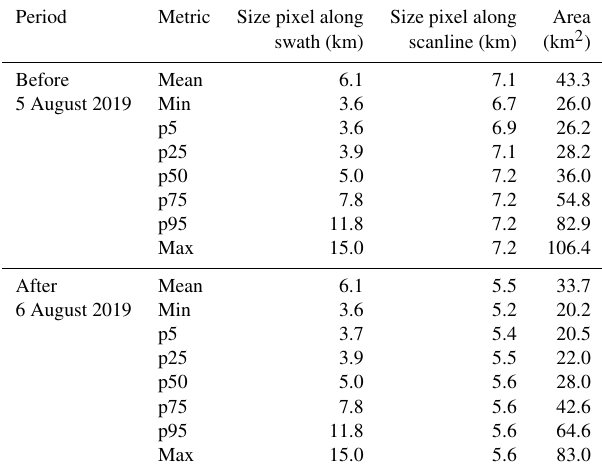
Table A1. Statistics on the pixel dimensions of a given TROPOMI L2 file before and after 6 August 2019. p X here corresponds to the X th